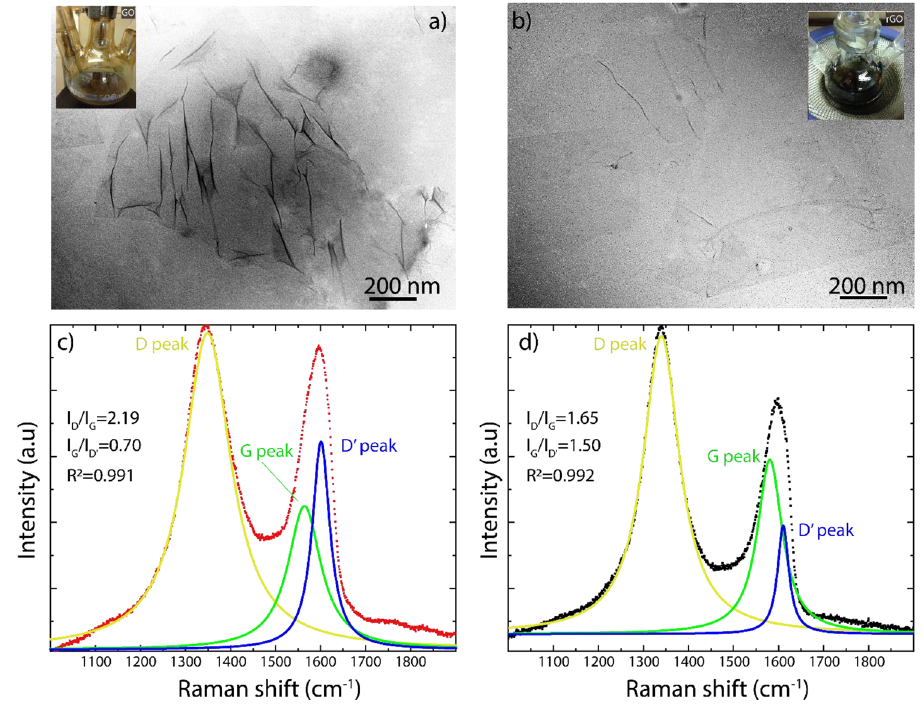
Figure 1. TEM and Raman studies. TEM images of ( a ) GO and ( b ) rGO. Raman spectra of ( c ) GO and ( d ) rGO. Inset images show the optical transformation of GO (yellowish suspension) into rGO (blackish